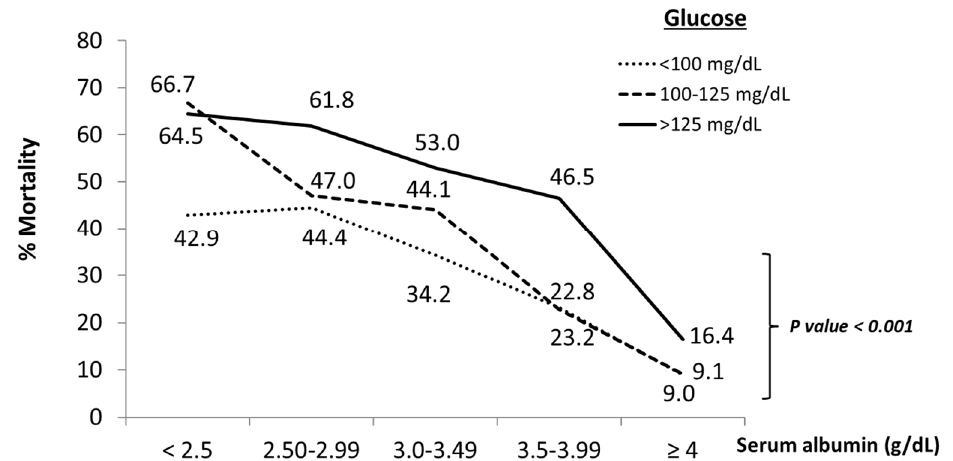
Figure 3. Effect of glucose levels on association between increased serum albumin and decreased mortality rates in COVID-19 patients. The graph shows change in rates (%) of in-hospital mortality at 30 days from all causes associated with increased serum albumin levels by low (<100 mg/dL), normal (100 to 125 mg/dL) and high (>125 mg/dL) glucose levels on admission in COVID-19 patients. Data obtained from the multi-center cohort-study on impact of admission serum albumin levels for the prediction of <30 days in-hospital all-cause mortality in COVID-19 patients, Spain, August–November 2020 ( n = 1555).